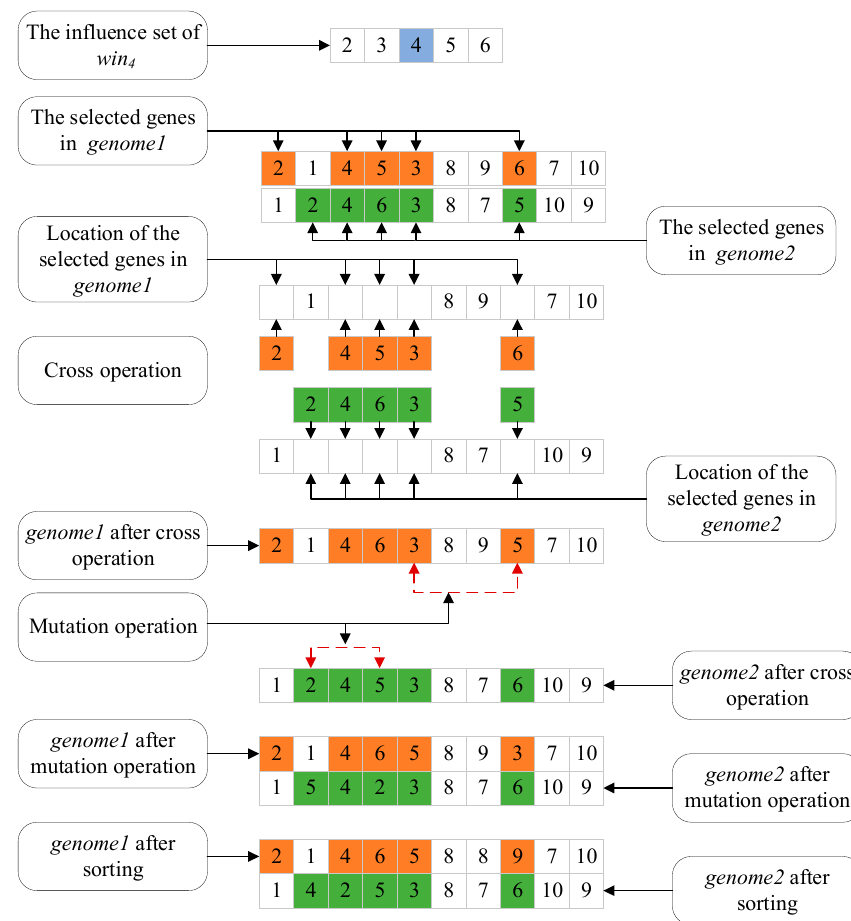
Figure 8. The key steps of influence set crossover-mutation operator (ISCMO).